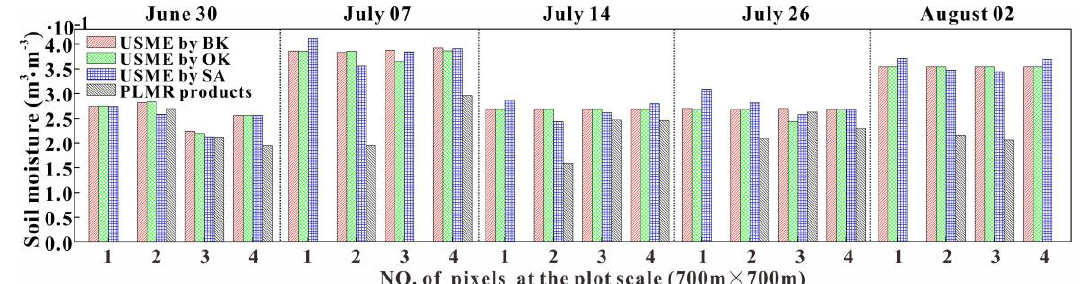
Figure 10. PLMR soil moisture products and upscaled soil moisture estimations (USME) (m 3 × m −3 ) at the scale series by block kriging (BK), ordinary kriging (OK), and simple averaging (SA) on five acquisition days. Table 6. Comparison of upscaled soil moisture estimations at plot scale P θ against remote sensing data R S θ using root mean square error (RMSE). Acquisition Time P R S () , R M S E θθ (m 3 ·m −3 ) June 30 July 7 July 14 July 26 August 2 Block Kriging 0.036 0.149 0.066 0.040 0.143 Ordinary Kriging 0.036 0.149 0.066 0.041 0.143 Simple Averaging 0.035 0.132 0.053 0.047 0.135